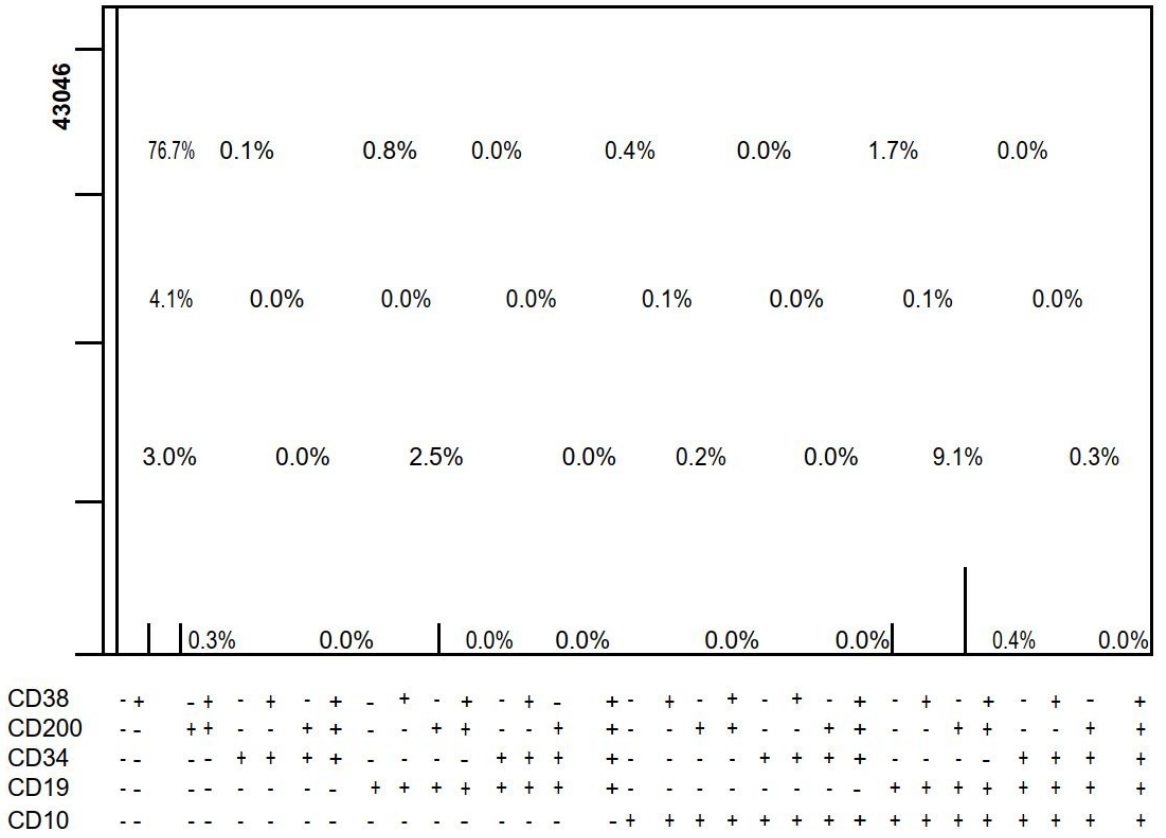
Figure 1. PRISM of one case at D14 with minimal residual disease. CD200 Cutoff Value